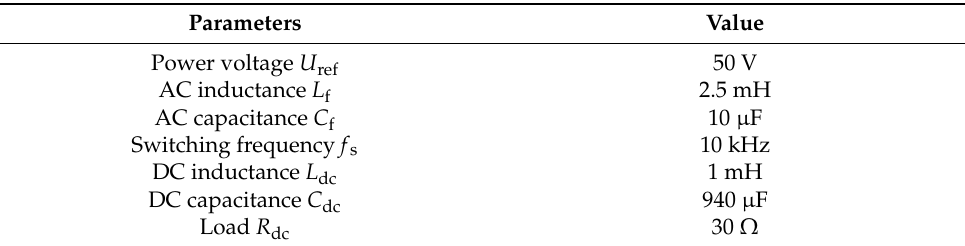
Figure 14. Experimental setup. Table 5. Experimental